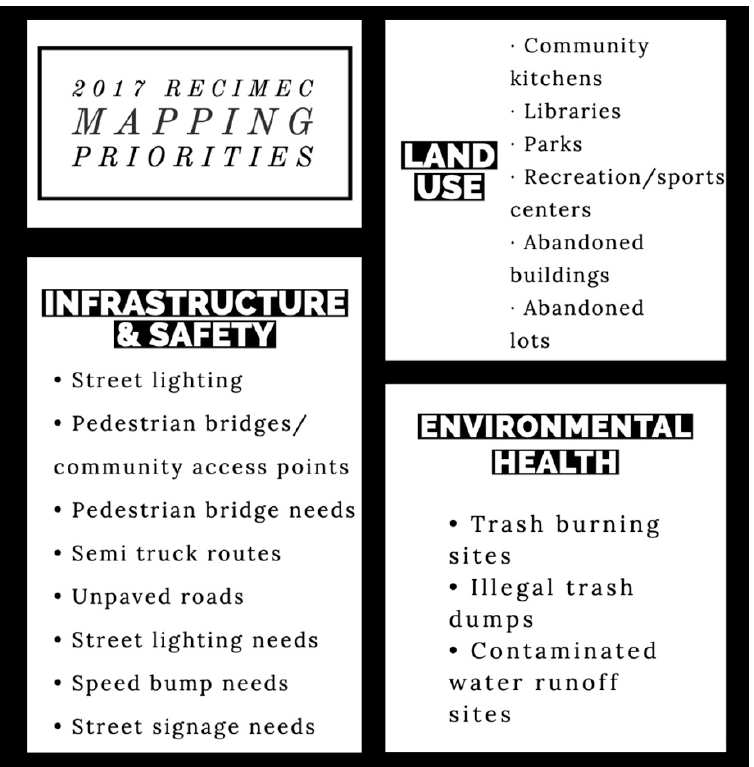
Figure 4. 2017 Red de Ciudadanos por el Mejoramiento de las Comunidades (RECIMEC) mapping priorities.